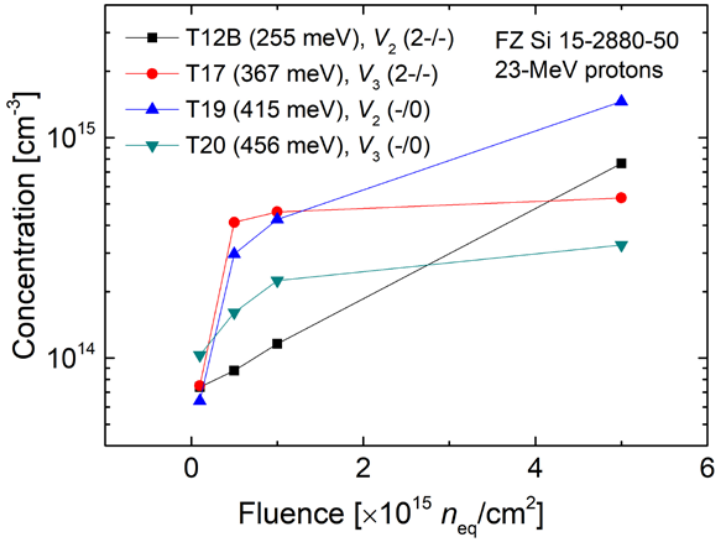
Figure 5. Variation in the concentrations of the T12B and T19 traps, attributed to the (2− / −) and (−/0) charge state changes of divacancies, respectively, as well as of the T17 and T20 traps, attributed to the (2− / −) and (−/0) charge state changes of trivacancies, respectively, with an increase in the fluence from 1×10 14 to 5×10 15 n eq /cm 2 during the irradiation of HPSi samples with 23 - MeV protons.